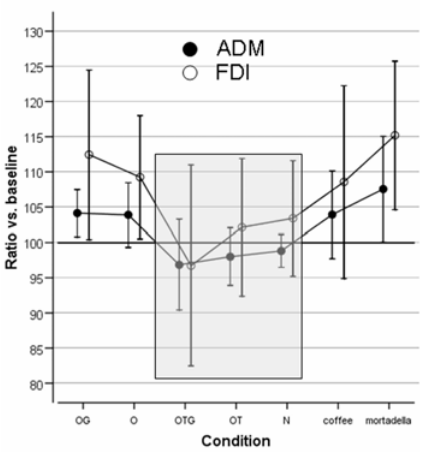
Figure 2. Results of Experiment 1. Mean percent changes of log- transformed MEP amplitude from hand muscles (FDI and ADM) versus the control condition Basal (the 100% reference line). The condition ‘‘Neutral’’ (N) was similar to Basal. Sniffing unimodal olfactory (O), bimodal olfacto-gustative (OG), and natural odorants as coffee and mortadella increased MEPs’ size. Such facilitation of corticospinal output disappeared when sniffing odorants with a trigeminal component (OT and OTG, grey area). Notably, no cognitive tasks except sniffing are required to subjects. Statistics are in the text.